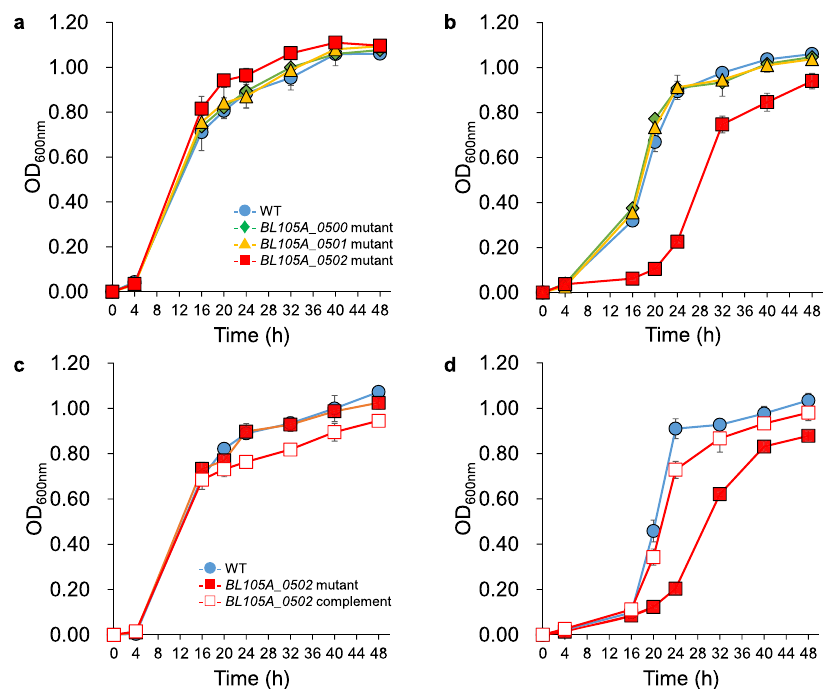
Fig. 2 Growth pro fi les of B. longum subsp. longum 105-A wild-type, insertional mutants and a complemented strain. Each strain was cultured in modi fi ed MRS medium supplemented with lactose ( a )( c ) or lactulose ( b )( d ) as the sole carbon source. OD 600nm values were determined at the indicated time points. The presented data are the mean ± SD of at least three independent